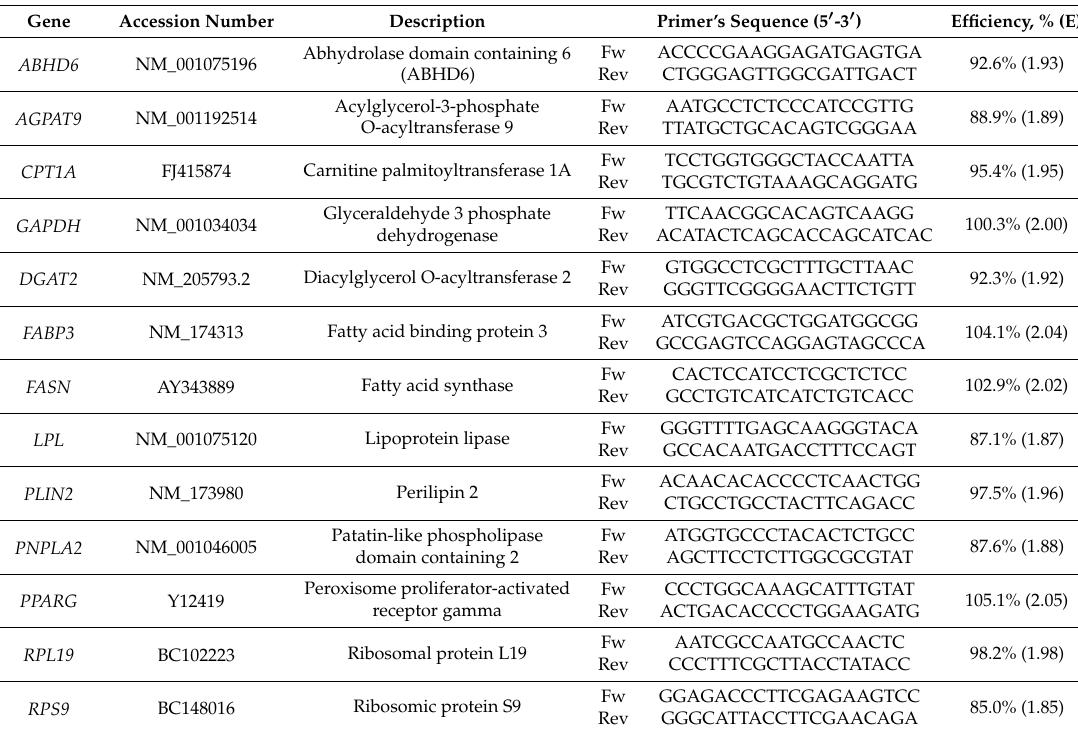
Table A3. List of primers used for RT-qPCR analysis of gene expression in bovine ovarian cells.